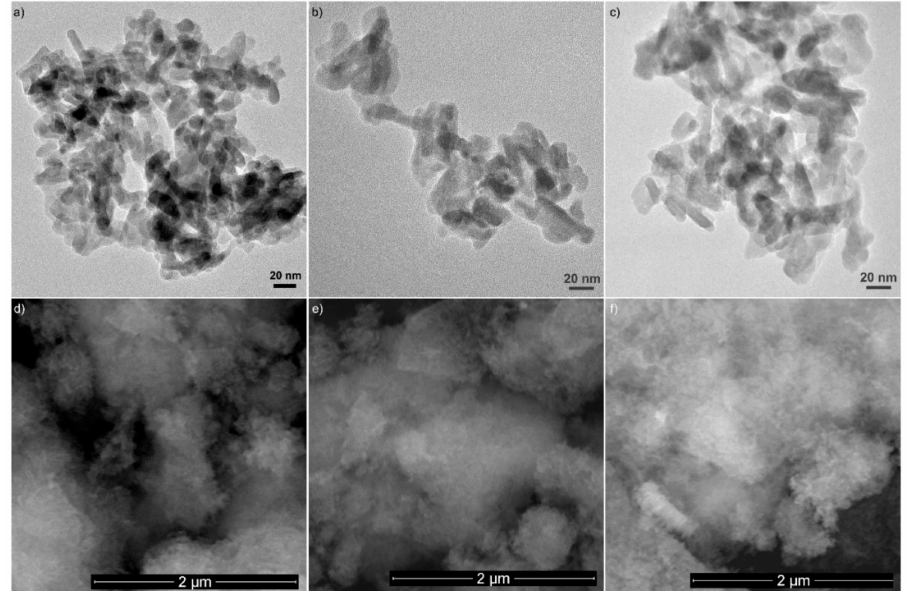
Figure 2. TEM micrographies and SEM images and of the HApAg samples with x Ag = 0 ( a , d ), x Ag = 0.05 ( b , e ) and x Ag = 0.2 ( c , f ).